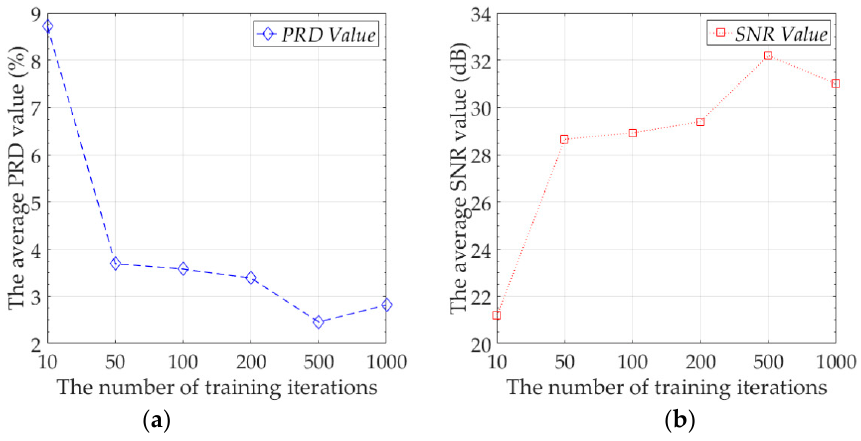
Figure 5. ( a ) The average PRD value under di ff erent number of training iterations, ( b ) The average SNR value under di ff erent training